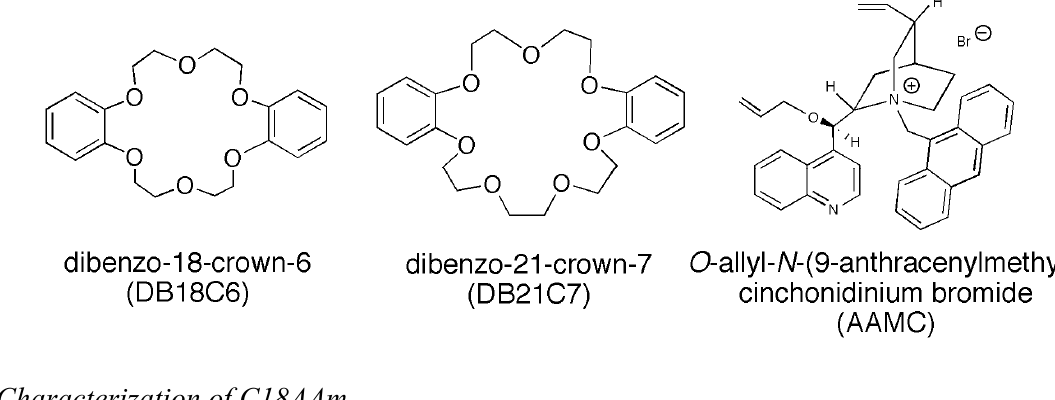
Figure 11. Chemical structures of various transporters.